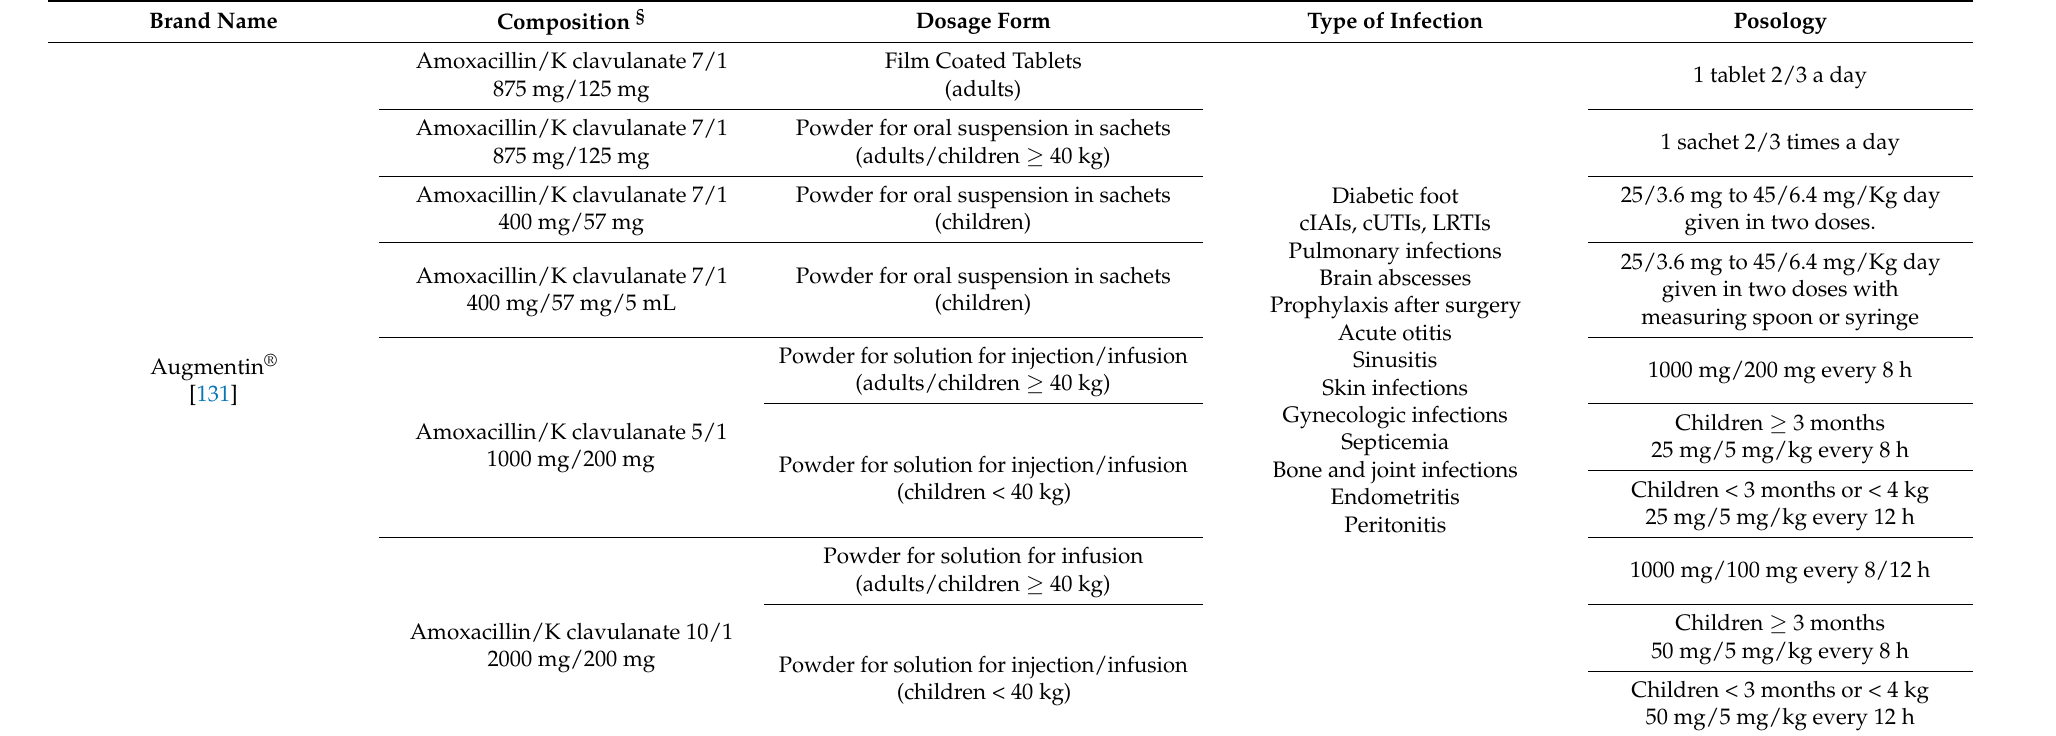
Table 4. BLAs/BLEsIs combinations currently marketed in Europe and USA with the most common brand names, the available dosage forms, the suggested clinical uses, and